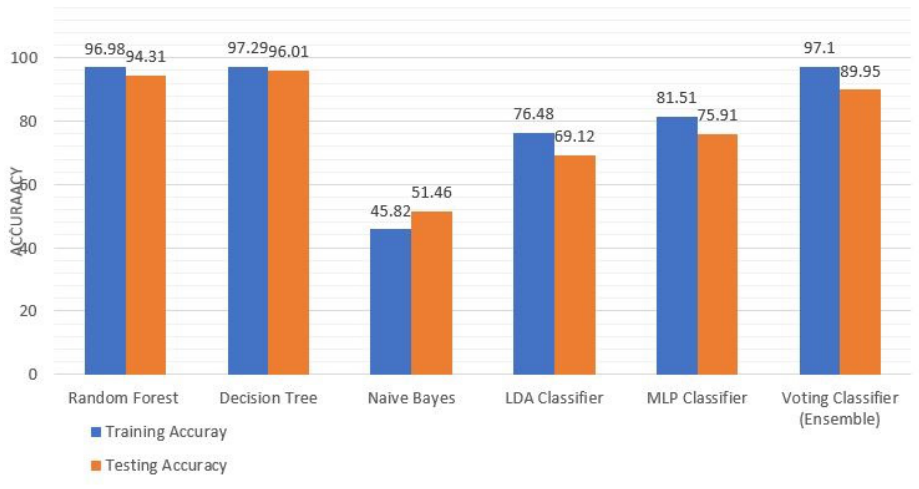
Figure 11. Accuracy comparison of testing and real-time deployed